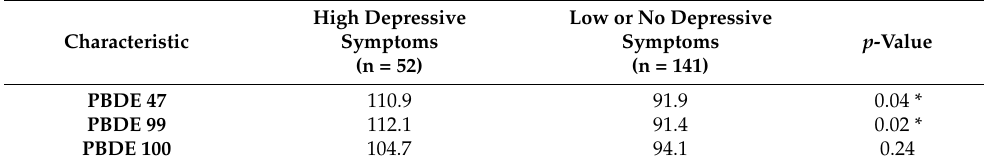
Table 4. Mean PBDE concentrations (pg/mL) in serum and risk of antenatal depression among African American women at 8–14 weeks gestation (n = 193).